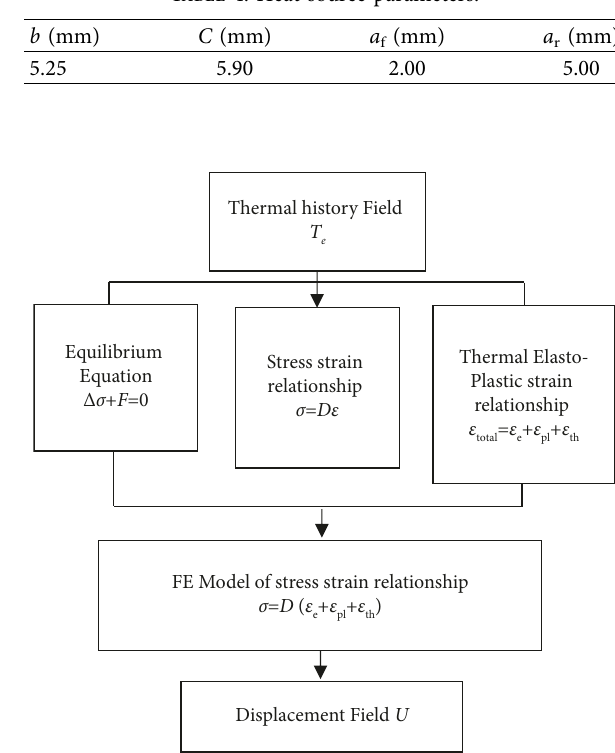
Table 4: Heat source parameters.